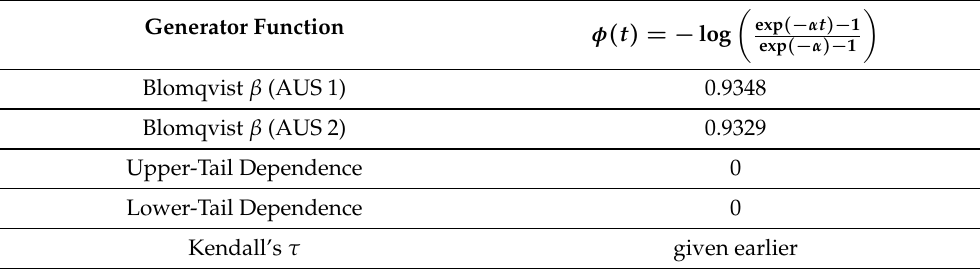
Table 4. Dependence of the Frank